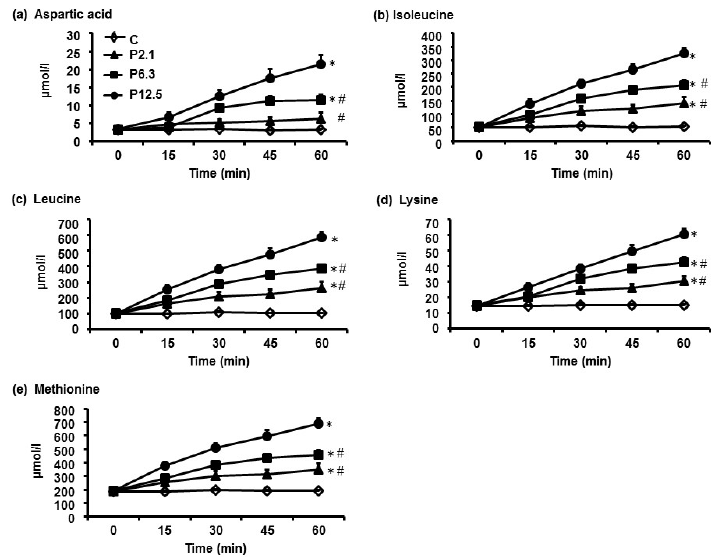
Figure 1. The temporal profiles of ( a ) aspartic acid; ( b ) isoleucine; ( c ) leucine; ( d ) lysine; and ( e ) methionine, the five amino acids whose plasma concentrations increased the most in response to increasing loads of ID protein. Data are means ± SEM, n = 16. The infusions consisted of either saline (C), or of 2.1 kJ/min (P2.1), 6.5 kJ/min (P6.3), or 12.5 kJ/min (P12.5) of hydrolysed whey protein, each infused at 4 mL/min for 60 min. Main effect of protein load was determined by one ‐ way ANOVA and post ‐ hoc comparisons between two loads were done using Bonferroni’s correction; statistical significance was accepted at p < 0.05. * Significantly different from C. # Significantly different from P12.5 ( p < 0.05).